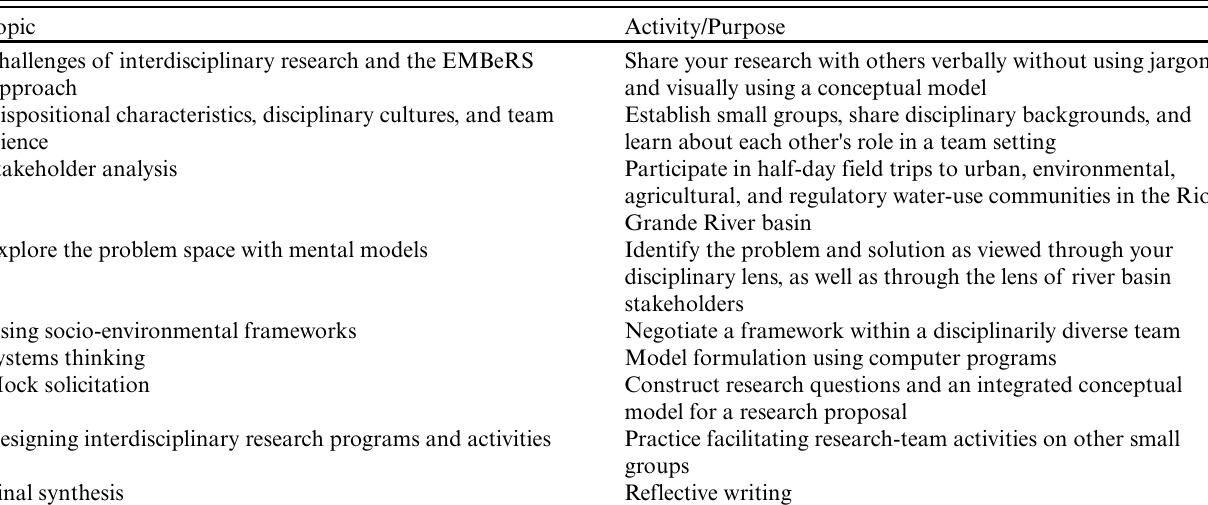
Table 1 . Employing Model-Based Reasoning in Socio-Environmental Synthesis (EMBeRS) workshop topics and activities, modified from 2017